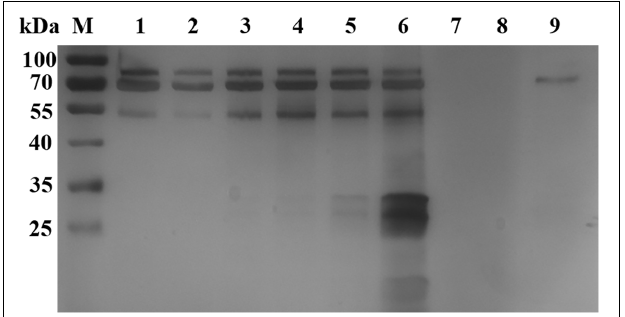
FIGURE 1 | Silver staining analysis of B. microti in vitro culture supernatant. Lane M: protein marker; Lanes 1–6: the supernatant samples were cultured in vitro for 4, 8, 18, 24, 48, and 72 h, respectively; Lanes 7–8, loading buffer; Lane 9, negative control samples collected after 72 h of